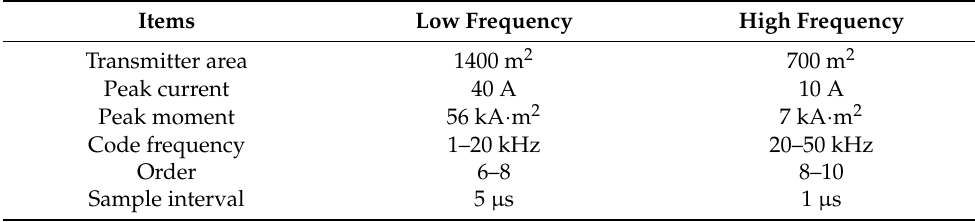
Table 1. System parameters for the LF and HF modes.